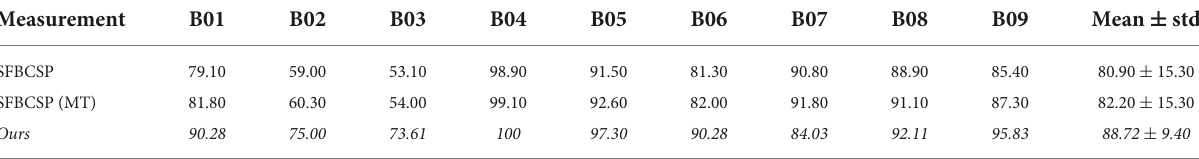
TABLE 4 Performance comparisons of our method and two similar ones, for dataset 2.